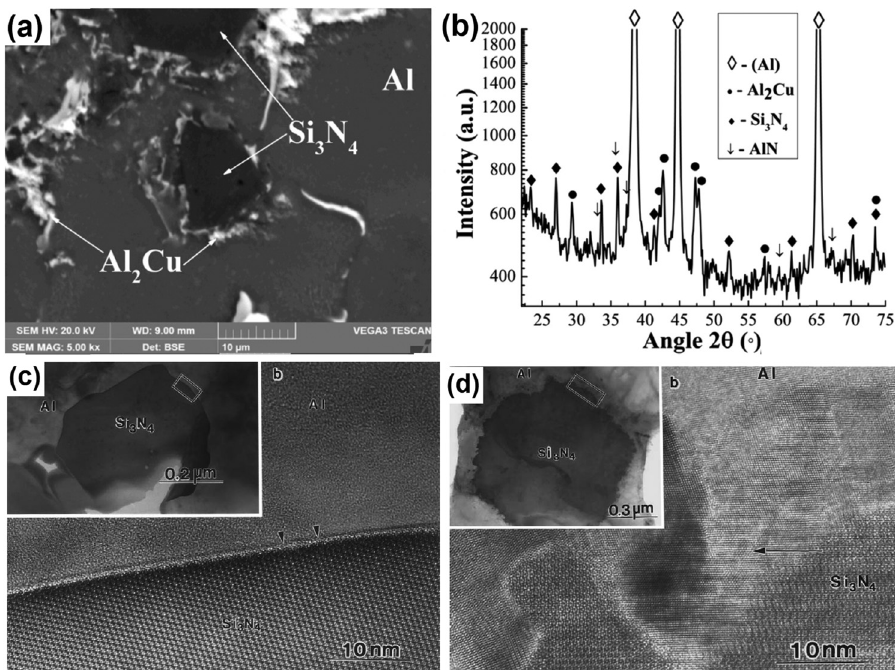
Figure 10: ( a ) SEM image of a squeeze cast Al – 5 Cu/7% Si 3 N 4 composite and ( b ) XRD analysis of this composite with the presence of di ff erent peaks. ( Reproduced with permission from [ 157 ] . ) ( c and d ) TEM and HRTEM images of Si 3 N 4 particles for tensile deformed. ( c ) Al – Cu/Si 3 N 4 composite and ( d ) Al – Cu – Mg/Si 3 N 4 composite ( Reproduced with permission from [ 173 ] . )